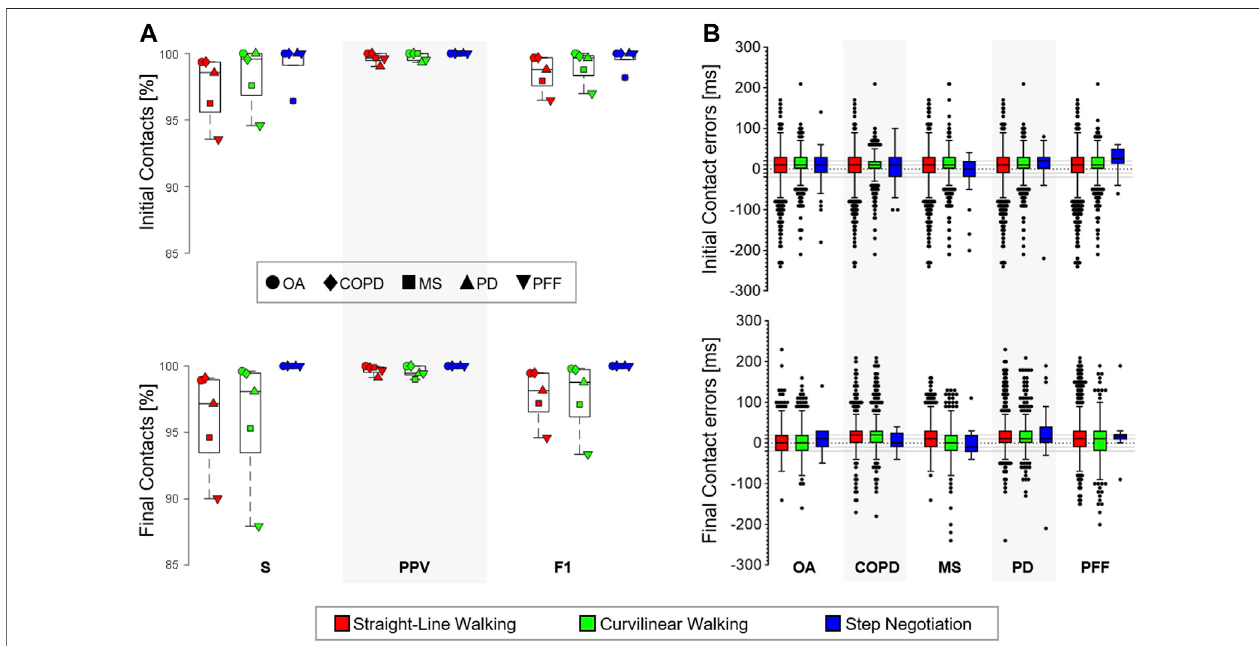
FIGURE 3 | (A) Sensitivity ( S ), positive predictive values (PPV), and F1 scores observed using the selected method in the older adults (OA), chronic obstructive pulmonary disease (COPD), multiple sclerosis (MS), Parkinson disease (PD), and proximal femur fracture (PFF) cohorts in the three walking conditions: straight-line walking, curvilinear walking, and step negotiation. (B) Box-plots (minimum, lower quartile, median, upper quartile, and maximum) of the error for the TP initial and fi nal contacts (ms) observed using the selected method in the fi ve (OA, COPD, MS, PD, and PFF) cohorts during the three walking conditions. Outliers are also